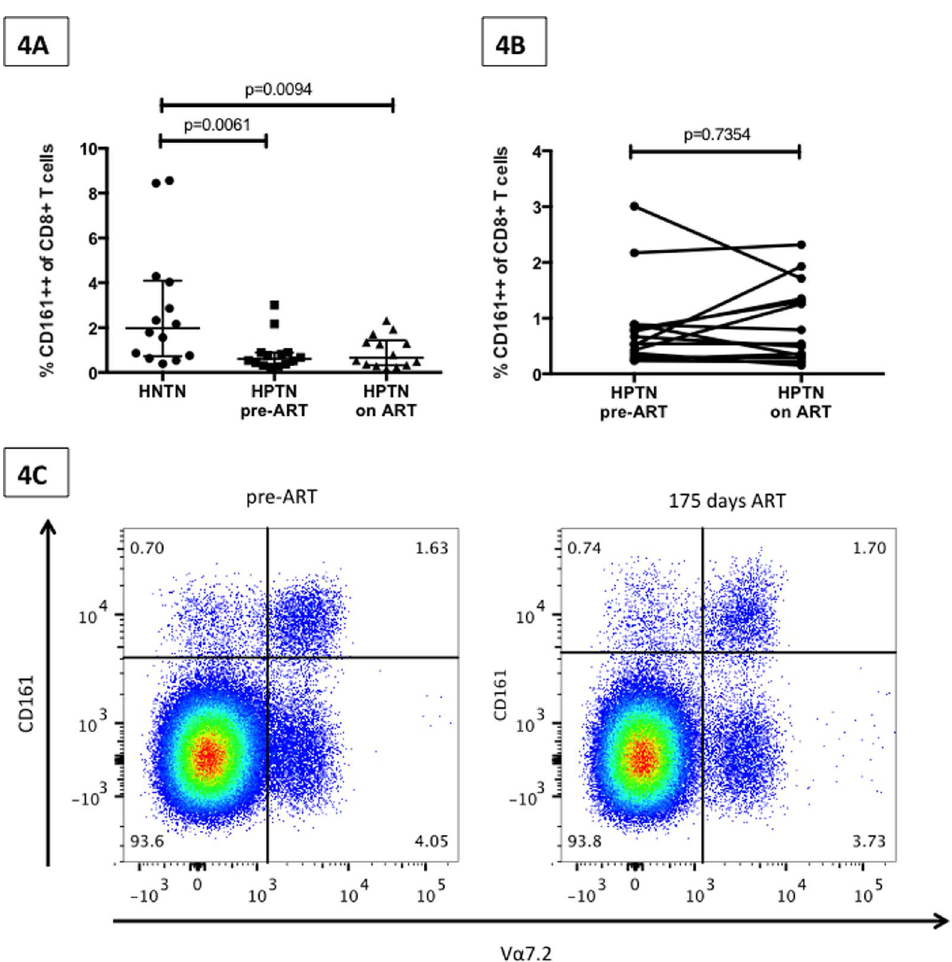
Figure 4. Impact of Antiretroviral treatment (ART) on CD161 ++ CD8 + T cell frequency. Figure 4A: Graph displaying CD161 ++ CD8 + T cell frequency (median and interquartile range) from 14 HIV negative TB negative individuals (HNTN) and 14 HIV positive TB negative individuals (HPTN) prior to ART initiation (pre-ART) and on virally suppressive ART (on ART). P-value reported from two-sided Mann-Whitney tests with threshold for significance p=0.025 after Bonferroni correction for 2 comparisons. Figure 4B: Paired CD161 ++ CD8 + T-cell frequencies in HIV-positive individuals prior to and following virally suppressive ART (p-value reported for Wilcoxon matched pairs test). Figure 4C: FACS plots (gated on the CD8 + T cell population) displaying the lack of change in the CD161 ++ CD8 + population (co-stained with the MAIT cell semi-invariant TCR, V a 7.2) prior to and after 6 months of ART in a representative subject.